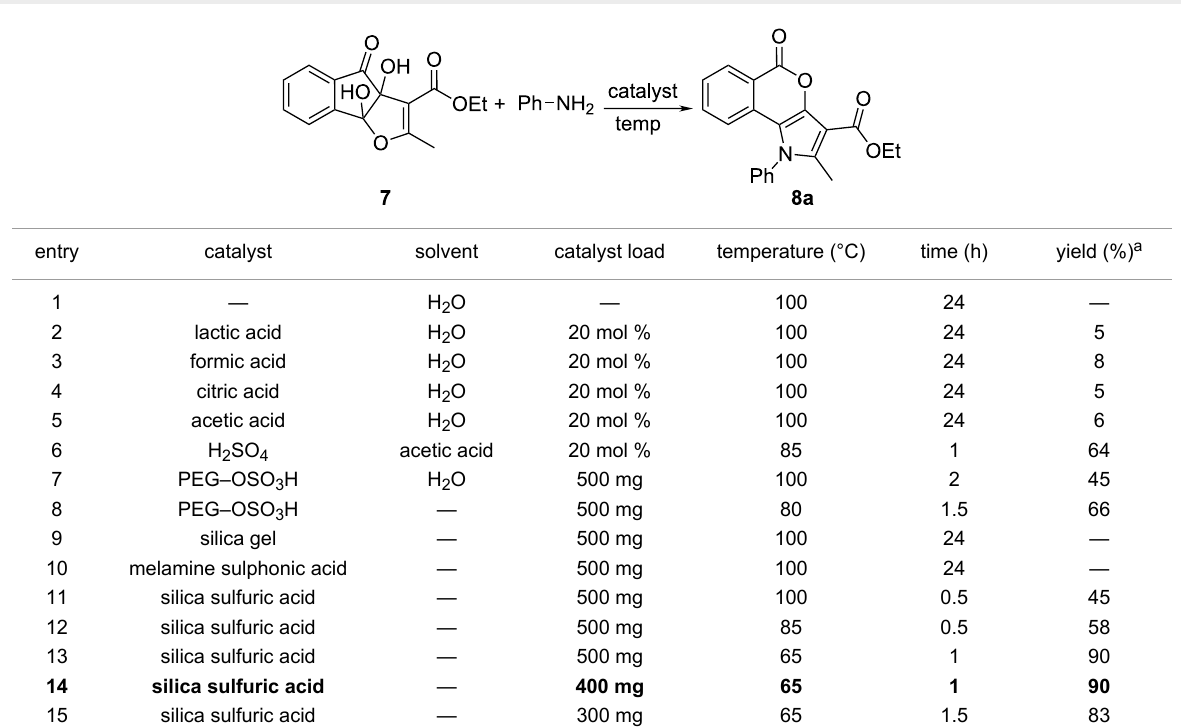
Table 1: Optimization of reaction conditions for the synthesis of 8a